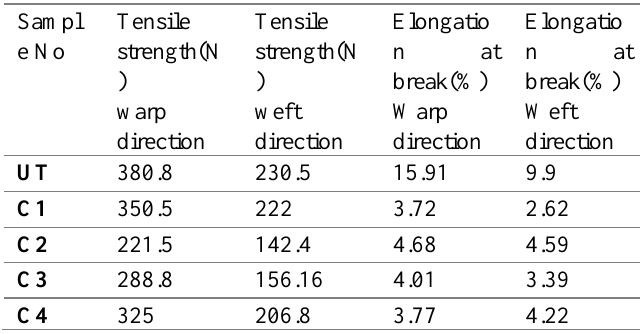
Tensile strength results